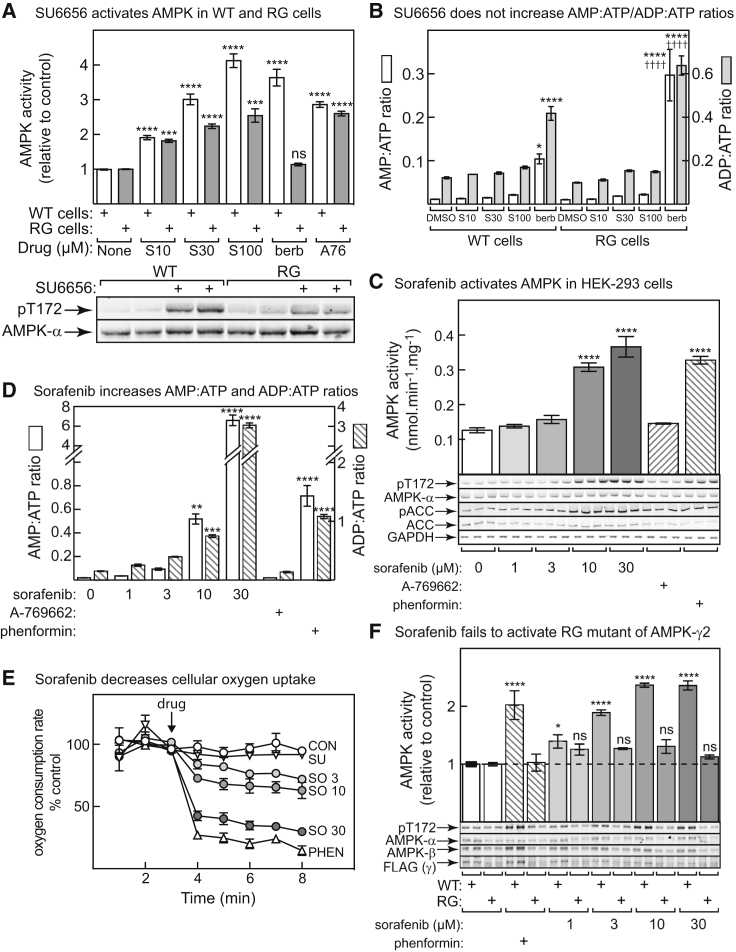
Sorafenib, but Not SU6656, Activates AMPK by Inhibiting Mitochondrial Metabolism and Increasing Cellular AMP(A) Top: HEK293 cells expressing wild-type (WT) AMPK-γ2 or the R531G (RG) mutant were treated for 1 hr with SU6656 at 10, 30 or 100 μM (S10, S30, S100), 300 μM berberine (berb) or 300 μM A769662 (A76) and AMPK assayed (mean ± SEM, n = 4); bottom: blots of Thr172 phosphorylation and total AMPK-α in cells (n = 2) incubated with DMSO or 100 μM SU6656 for 1 hr.(B) WT or RG cells were treated as in (A) and nucleotides extracted for analysis (mean ± SD, n = 3).(C) Effects of incubation (1 hr) of WT HEK293 cells in increasing concentrations of sorafenib, A769662 (300 μM) or phenformin (10 mM) on AMPK activity (top, mean ± SEM, n = 3) and on phosphorylation of Thr172 and ACC (bottom).(D) Effects of incubation of WT HEK293 cells (1 hr) in increasing concentrations of sorafenib, A769662 (300 μM) or phenformin (10 mM) on cellular AMP:ATP/ADP:ATP ratios (mean ± SD, n = 3).(E) (See also Figure S2) Time courses of cellular oxygen uptake before and after addition of the indicated concentrations of sorafenib (SO, μM), SU6656 (100 μM) or phenformin (PHEN, 10 mM) (mean ± SEM, n = 4).(F) Effect of various concentrations of sorafenib or phenformin (10 mM) on activation (top, mean ± SEM, n = 3) or phosphorylation (bottom) of AMPK in cells expressing wild-type AMPK-γ2 (WT) or the R531G mutant AMPK-γ2 (RG).In all panels, asterisks show significant differences from DMSO controls (ns, not significant). In (B), daggers (†) show significant differences between results in WT and RG cells. *p < 0.05, **p < 0.01, ***p < 0.001, ****p < 0.0001, ††††p < 0.0001.